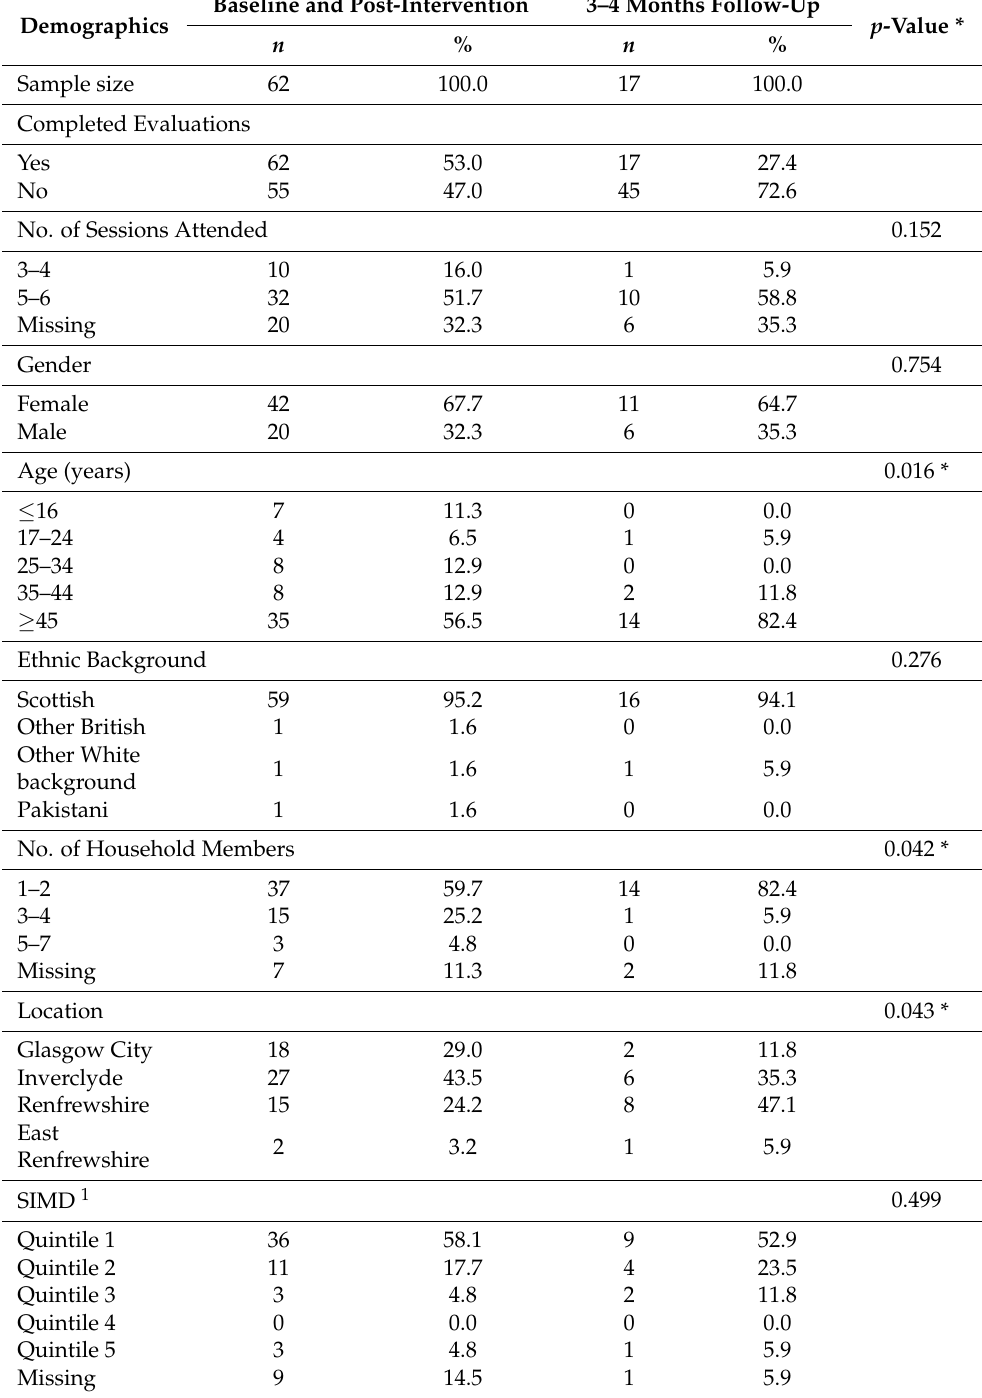
Table 1. Participant demographics of the Eat Better Feel Better 6-week cooking skills programme.